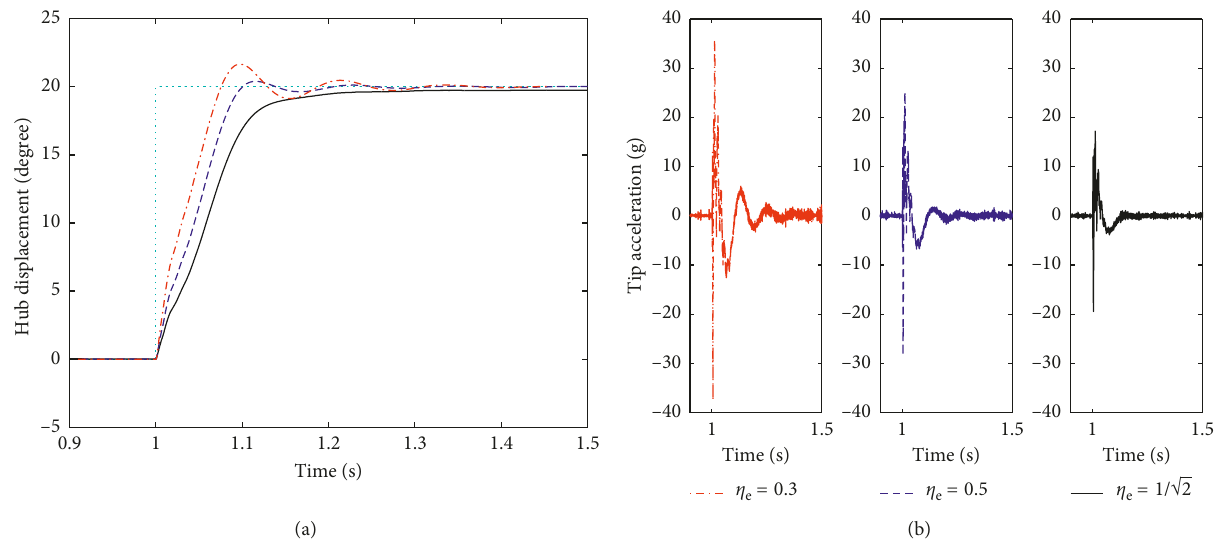
. 3 (dashed dotted line), 0 . 5 (dashed), and 1/ e (cid:31) 0